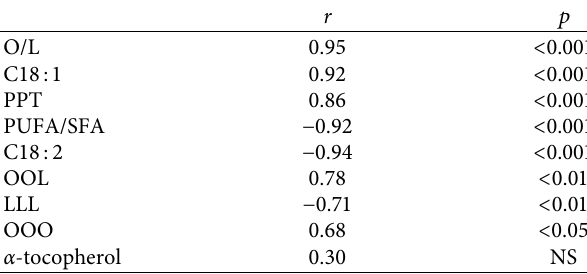
O: oleic, L: linoleic, PPT: total phenol content, PUFA: polyunsaturated fatty acids, SFA: saturated fatty acids, NS: no significance.